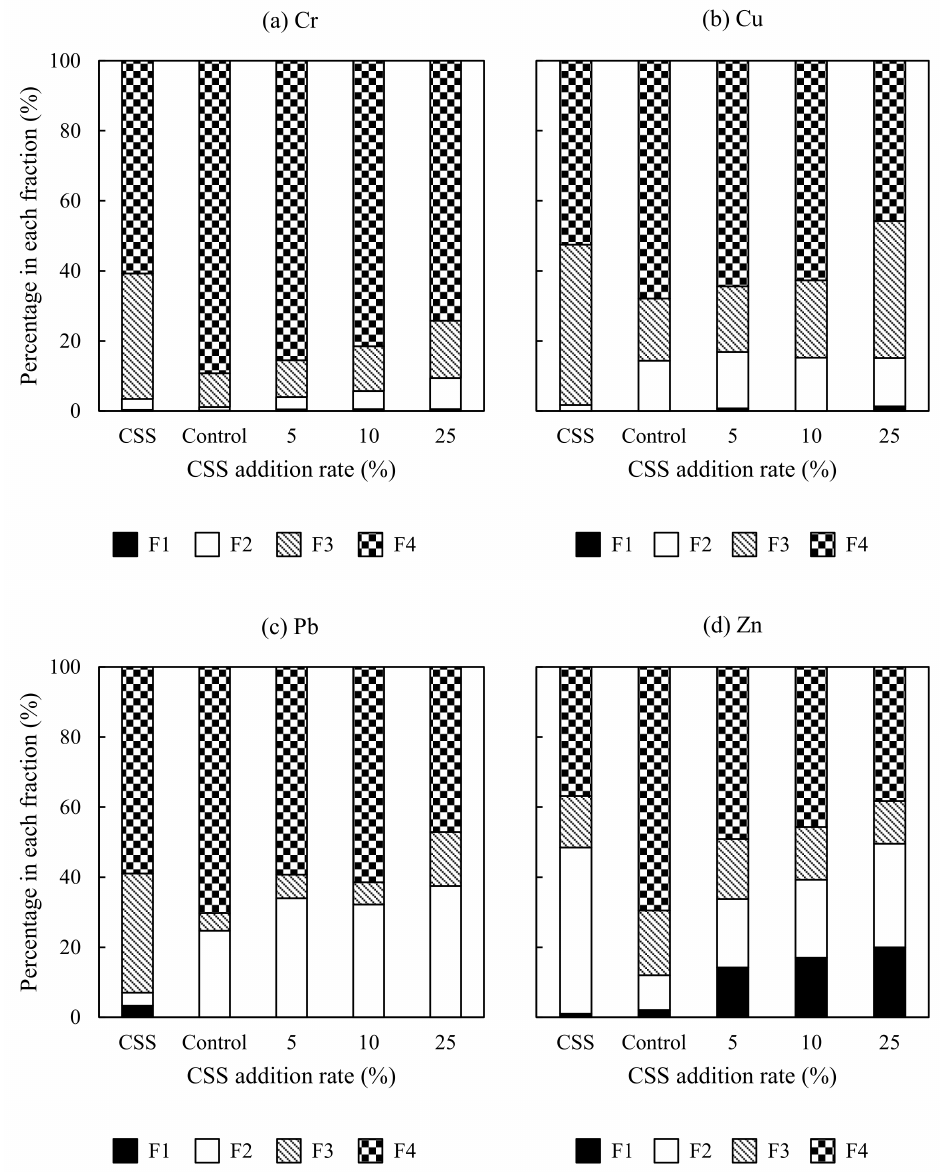
Figure 2. Heavy metal fractionation in the CSS, control, and amended soil. F1: exchangeable fraction; F2: reducible fraction; F3: oxidisable fraction; F4: residual fraction. ( a ) Cr fractionation in the CSS, control, and amended soil; ( b ) Cu fractionation in the CSS, control, and amended soil; ( c ) Pb fractionation in the CSS, control, and amended soil; ( d ) Zn fractionation in the CSS, control, and amended